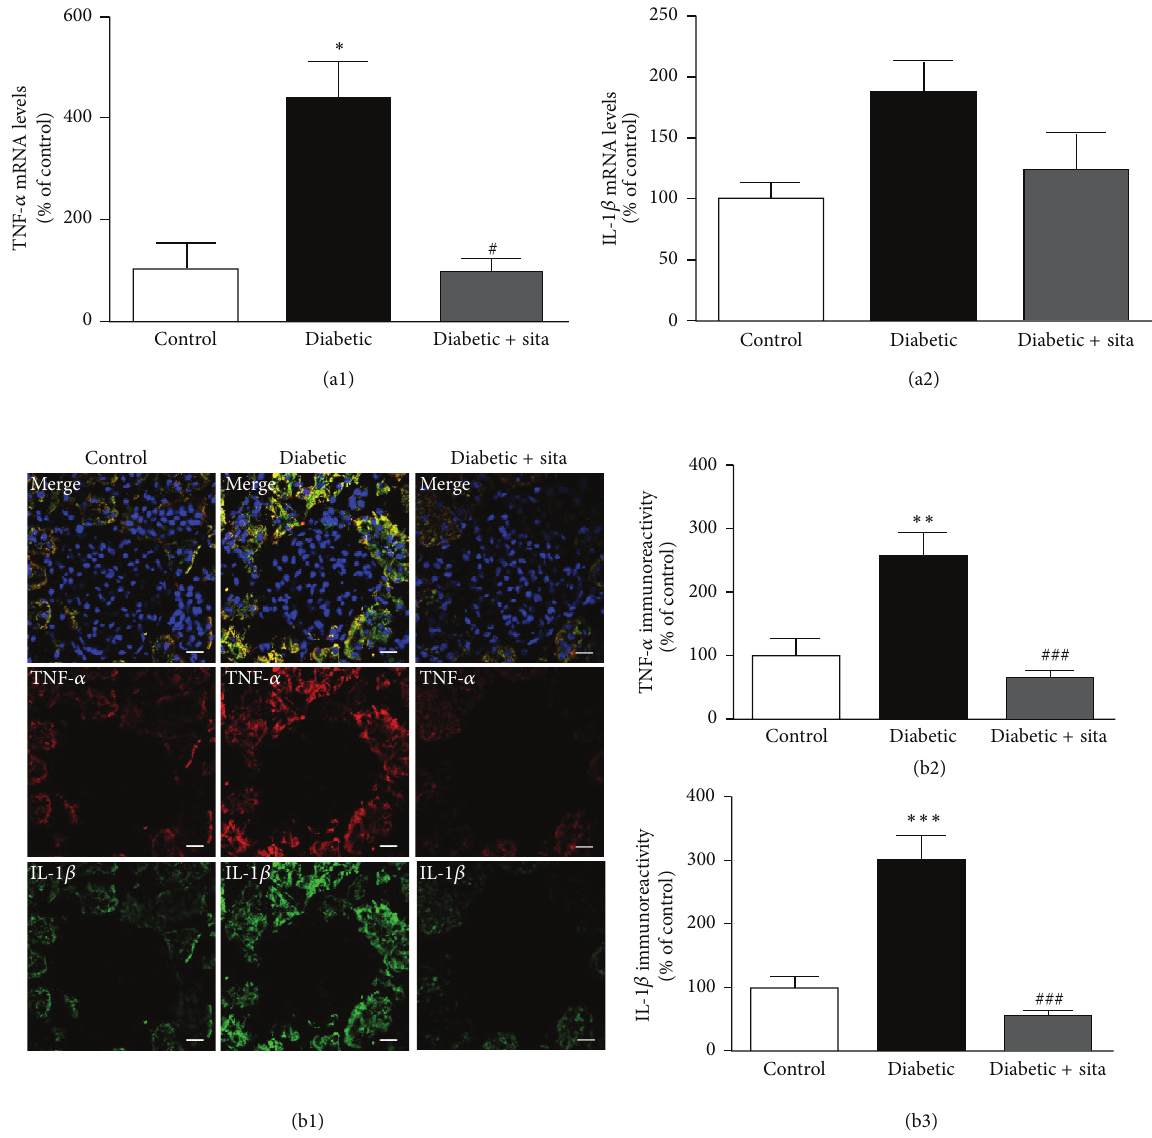
Figure 5: Sitagliptin decreases the proinflammatory cytokines IL-1 𝛽 and TNF- 𝛼 in the diabetic kidney. (a) mRNA expression of mediators of inflammation, TNF- 𝛼 (a1) and IL-1 𝛽 (a2), in the kidney. (b) Representative confocal images showing TNF- 𝛼 immunoreactivity (red), IL-1 𝛽 immunoreactivity (green), and nuclear staining with DAPI (blue) in kidney sections (b1), as well as immunoreactivity quantitation for TNF- 𝛼 (b2) and IL-1 𝛽 (b3). Bars = 20 𝜇 m. Data are expressed as percentage of control and represent the mean ± SEM ( 𝑛 ≥ 6 per group); ∗ 𝑃 < 0.05 , ∗∗ 𝑃 < 0.01 , and ∗∗∗ 𝑃 < 0.001 significantly different from control; # 𝑃 < 0.05 and ### 𝑃 < 0.001 significantly different from